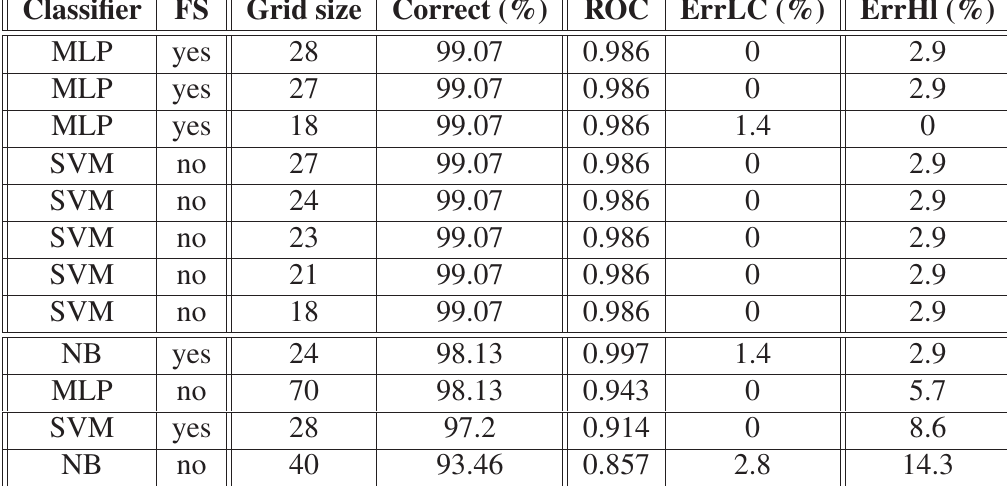
Table 2: The best classifiers achieve a correct classification of 99.07 % into lung cancer or healthy patients, which is measured using 10-fold cross-validation. The last 4 lines correspond to the best results for the other classifier/feature selection combinations. MLPs and SVM perform equally and in the same grid size range. FS = feature selection, Correct = percentage of correctly classified samples, ROC = area under the ROC curve, ErrLC = healthy patients falsely classified as lung cancer, ErrHl = lung cancer patients falsely classified as